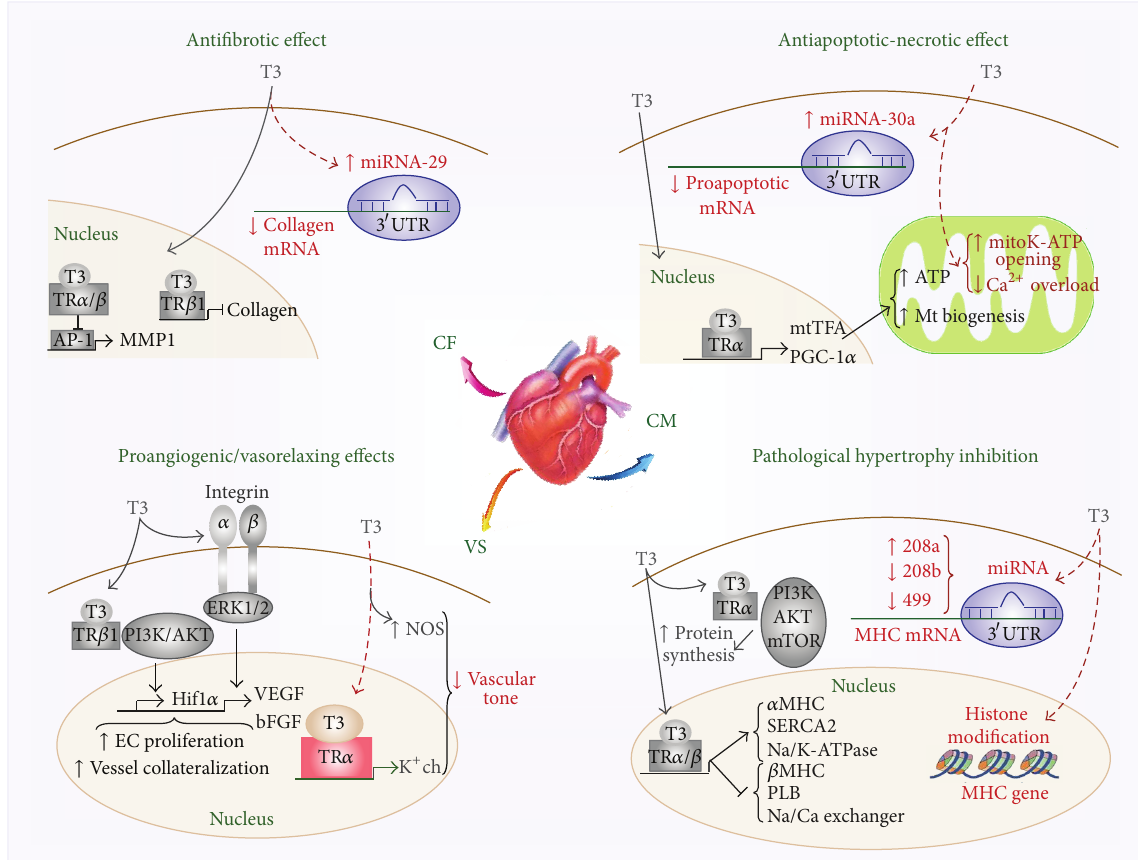
Figure 1: Schematic representation of cardioprotective mechanisms of T3. Coloured details refer to emerging findings, and established mechanisms are depicted in gray scale. Top left: antifibrotic effect on CF. T3 binding to TR 𝛽 / 𝛼 represses AP-1 activity resulting in MMP1 downregulation. Moreover T3 inhibits collagen synthesis through the classical genomic pathway mediated by TR 𝛽 1. The upregulation of the antifibrotic miRNA-29 by T3 opens a new window of investigation. Bottom left: proangiogenic and vasorelaxing effects of T3 on VS. T3 stimulates EC proliferation through the interaction with a plasma membrane integrin receptor. Signal transduction is mediated by activation of ERK1/2 and results in downstream transcription of proangiogenic genes such as VEGF and bFGF. The interaction of T3 with cytoplasmic TR 𝛽 1 activates PI3K/AKT. The signal cascade leads to stimulation of Hif1- 𝛼 with consequent increase of EC proliferation and vessel collateraization. In smooth muscle cells T3-mediated reduction of vascular tone is achieved by stimulation NOS activity and by the recently reported upregulation of K + ch. Top right: antiapoptotic and antinecrotic effects on CM. Classical genomic action of T3 increases PGC1- 𝛼 expression which in turn up-regulates mtTFA; the resulting increase of mitochondrial biogenesis and function improves cell viability. As recently reported, T3 might limit mitochondrial-mediated apoptosis and necrosis by reducing mitochondrial matrix calcium overload and byfavouringtheopeningofthecardioprotectivemitoK-ATPchannel.UpregulationoftheantiapoptoticmiRNA-30apathwaybyT3represents an emerging finding that encourages future researches. Right bottom: inhibition of CM pathological hypertrophy. Through the classical genomic mechanism, T3 regulates the expression of several genes critically involved in contractile function such as 𝛼 / 𝛽 -MHC, SERCA2, Na/K-ATPase, PLB, and Na/Ca exchanger. Another way of T3-mediated upregulation of protein expression requires the activation of the PI3K/AKT/mTOR axes. Histone modifications of MHC gene have been involved in T3-mediated regulation of MHC isoform